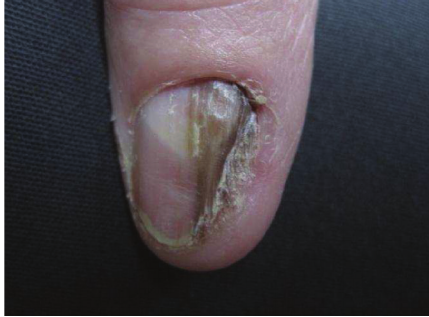
Figure 7: Hutchinson’s sign in a nail apparatus melanoma in situ